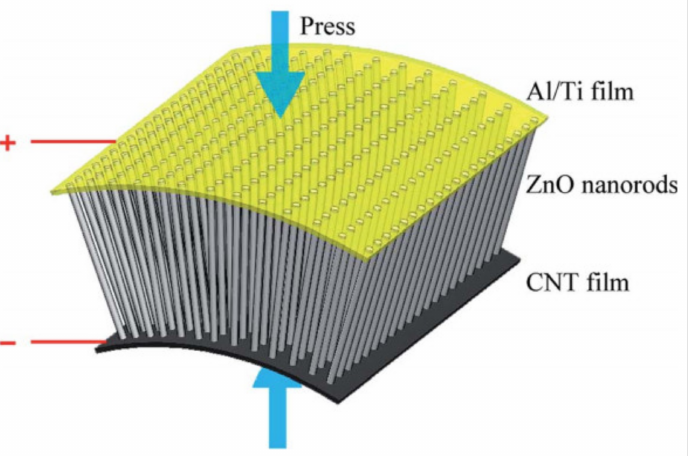
Figure 7. Scheme of a piezoelectric generator from metal/ZnO nanorods/CNT film [241]. Copyright the Royal Society of Chemistry